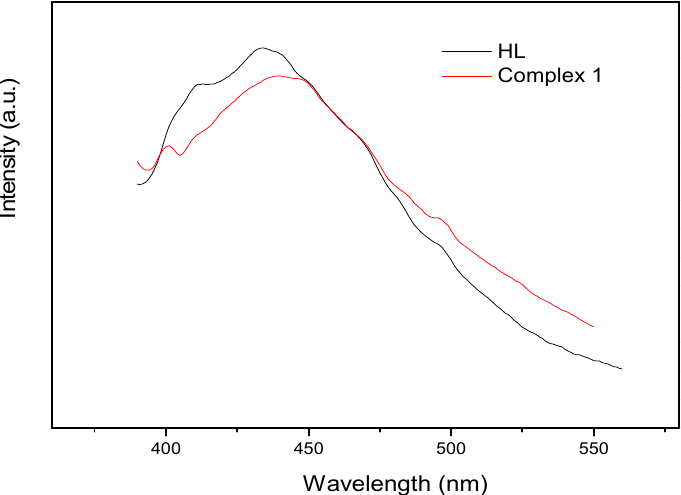
Figure 7. Solid-state photoluminescent spectra of HL ligand and complex 1 .